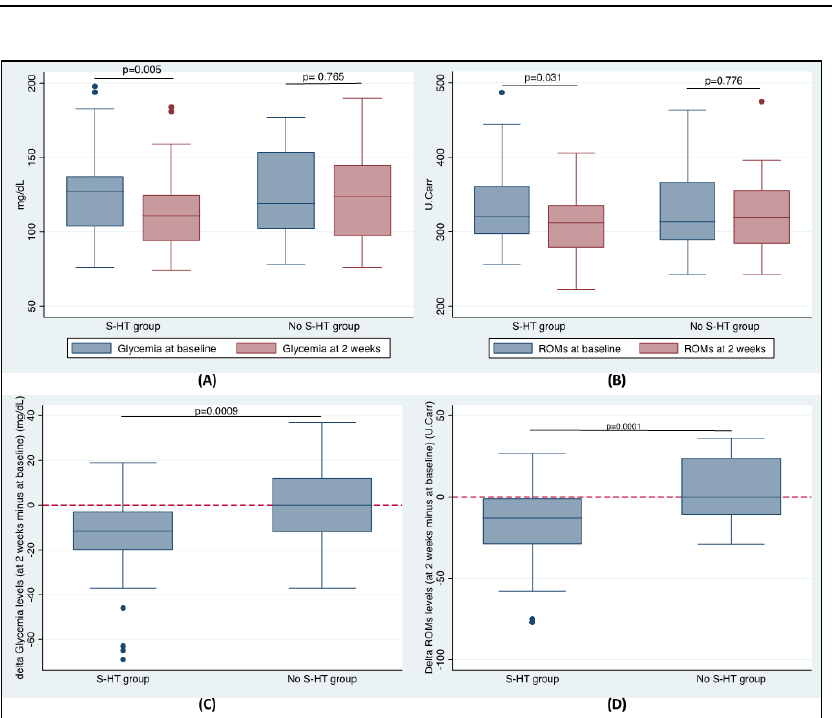
Figure 1. ( A ) Glycaemia and ( B ) ROMs median values at baseline and at 2 weeks in the two groups, and differences in the ( C ) glycaemic and ( D ) ROMs delta value between the groups. Delta value was C ) glycaemic and ( D ) ROMs delta value between the groups. Delta value was calculated as the difference between levels at 2 weeks and levels at baseline. and differences in the ( calculated as the difference between levels at 2 weeks and levels at